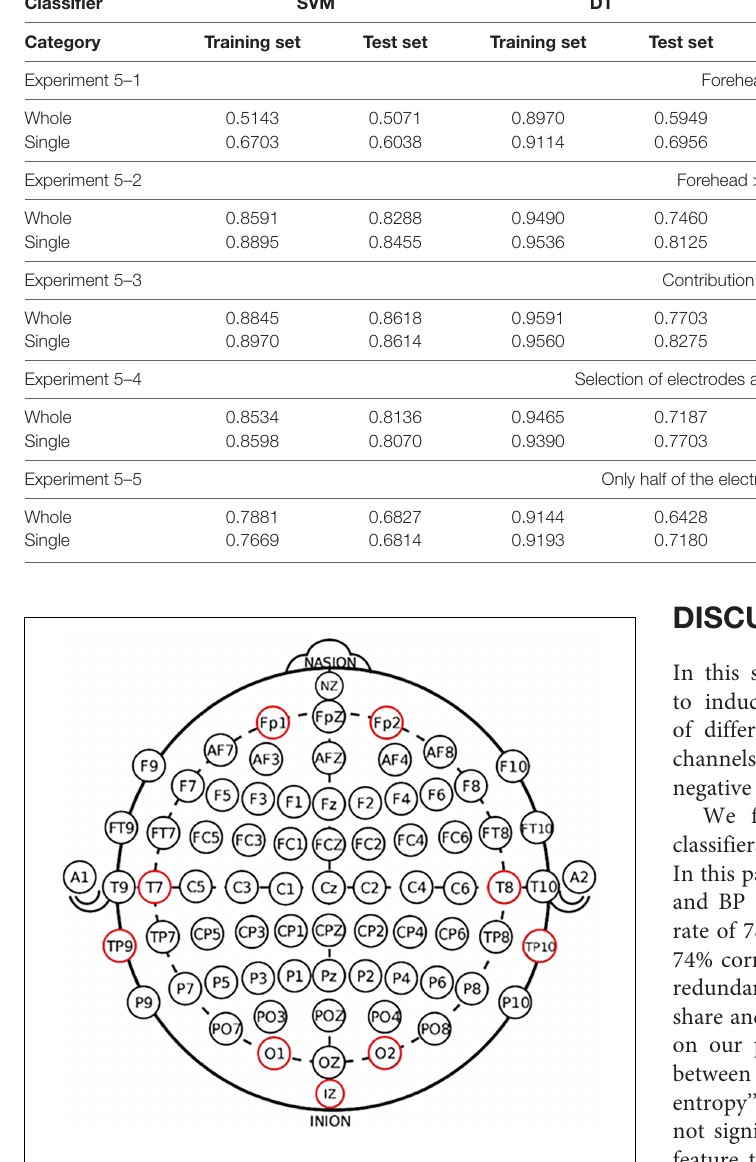
FIGURE 3 | Schematic diagram of the optimal electrode for multi-channel emotion recognition.